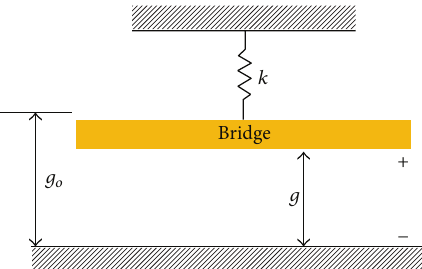
Figure 1: 1D lumped model for actuation voltage calculation.